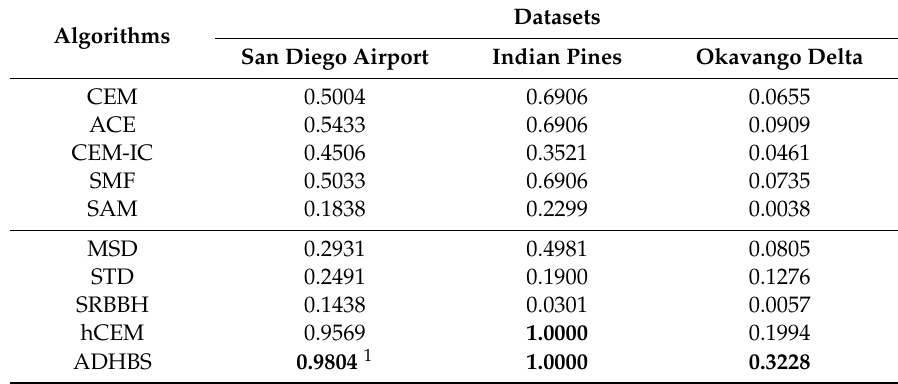
Table 2. Normalized AUC value at lower FAR (0.001) comparison for three datasets (keep four decimal